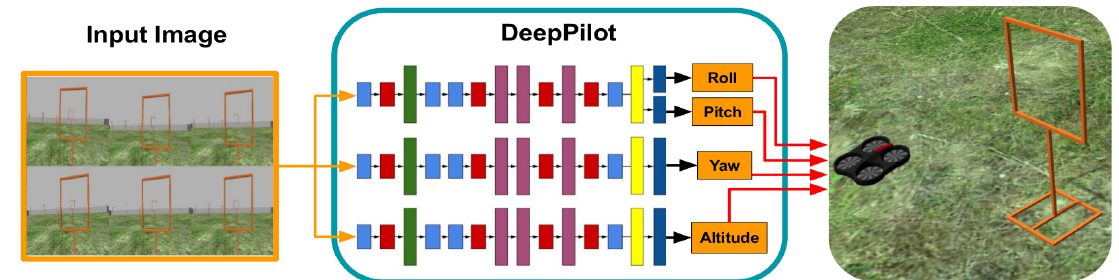
Figure 15. General control architecture in our approach based on an open-loop controller. The mosaic image corresponds to the observations of the world, in the racetrack. This image is passed to our CNN-based approach named DeepPilot to predict the flight commands ( φ , θ , ψ , h ) , which are fed into the drone’s inner loop controller. As output, the drone will be commanded to fly towards the gate. This controller can be seen as a reactive